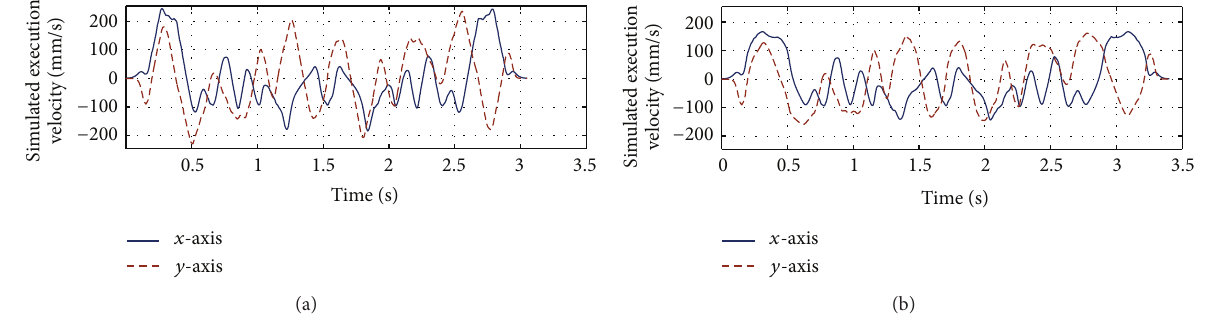
Figure 12: Simulated execution velocity curves of the (a) SMTT and (b) TEC-SMTT commands.